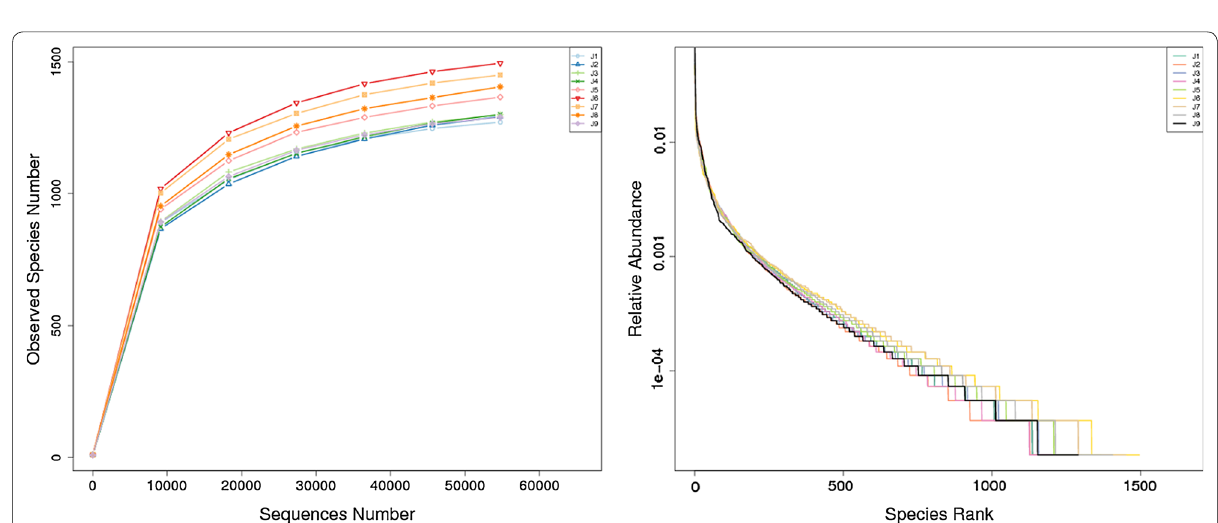
Fig. 1 Rarefaction curve analysis of nine golden takins. Repeated samples of OTU subsets were performed to evaluate whether further sampling would likely yield additional taxa, as indicated by whether the curve reached a plateau value. The y-axis indicates the number of OTUs detected, and the x-axis indicates the number of taxa in the sequence subset analyzed. Rank abundance curves were used to estimate the richness and evenness of taxa present in the samples. The y-axis indicates the relative abundance of OTUs, and the x-axis indicates the number of OTUs according to the relative abundance from large to small. The larger the span curve on the x-axis , the higher the species richness. The smoother the curve on the y-axis , the more even the species